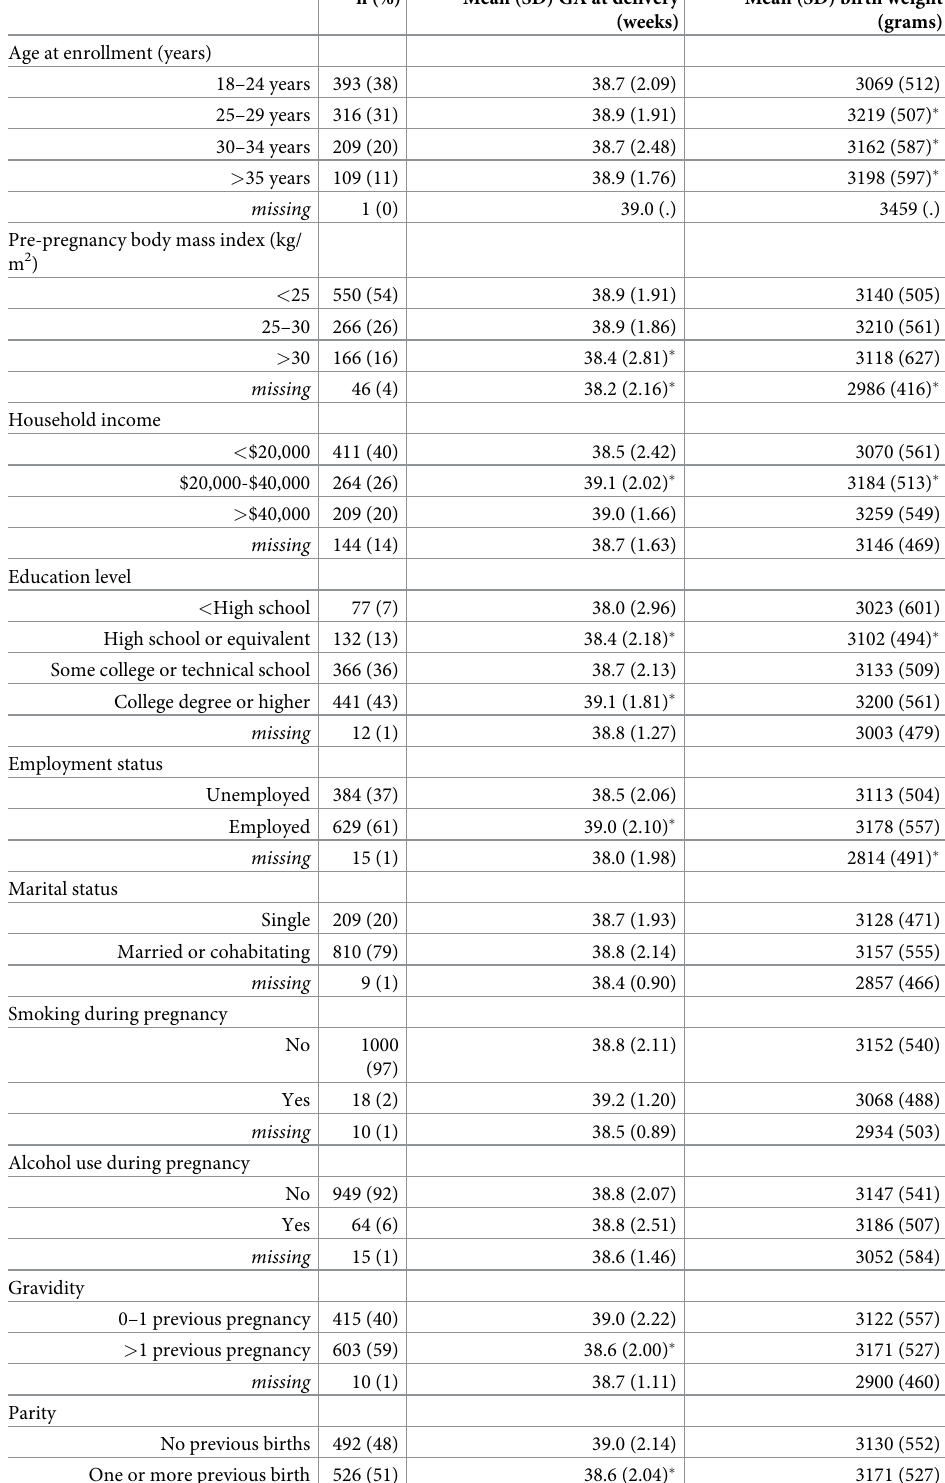
Table 1. Characteristics of mothers with singleton live births in the PROTECT cohort, 2011–2017 (N =